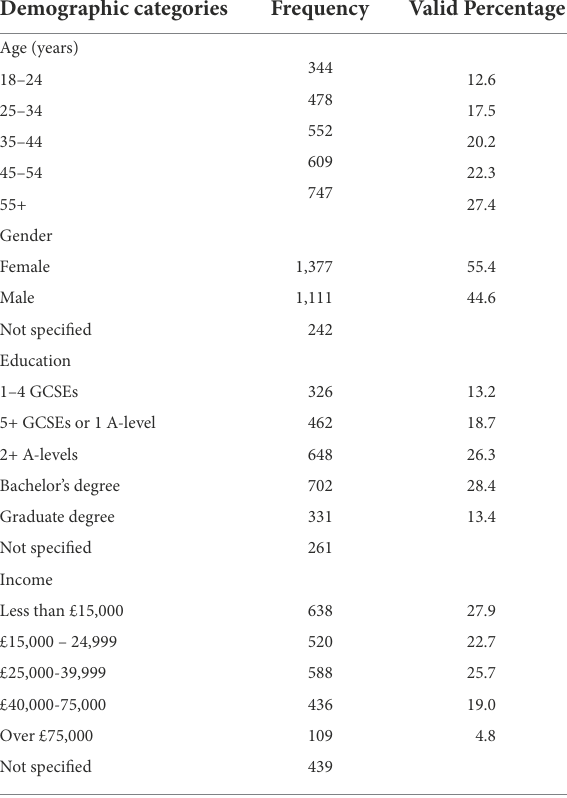
TABLE 2 Demographic characteristics of participants ( n = 2,481). Demographic